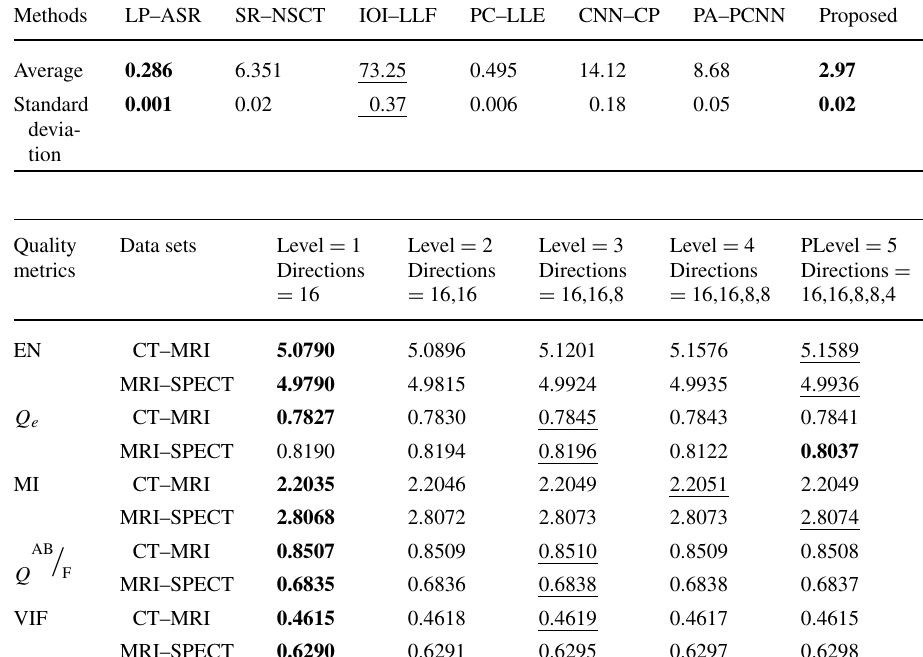
Table 3 Running time for different methods